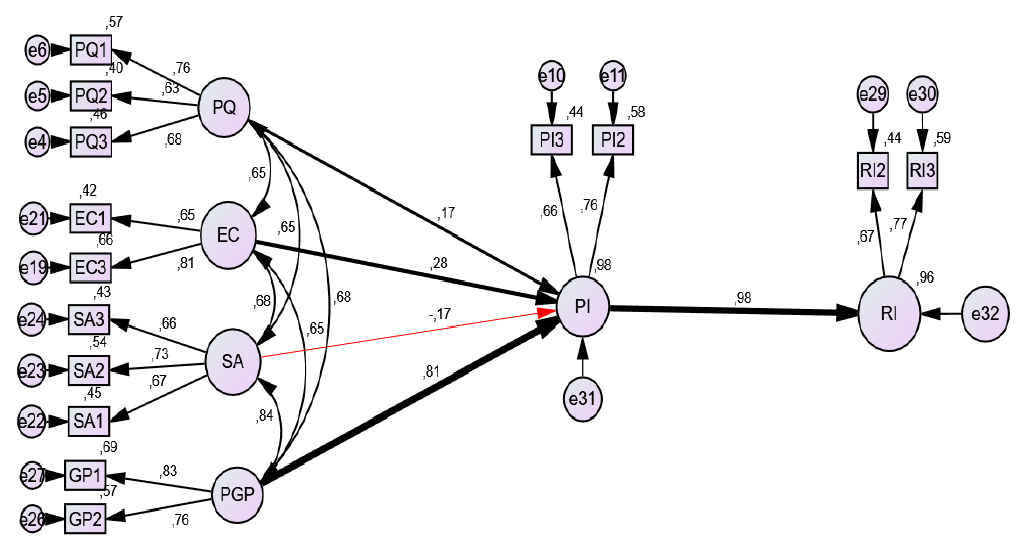
Figure 3: Structural equation model path diagram